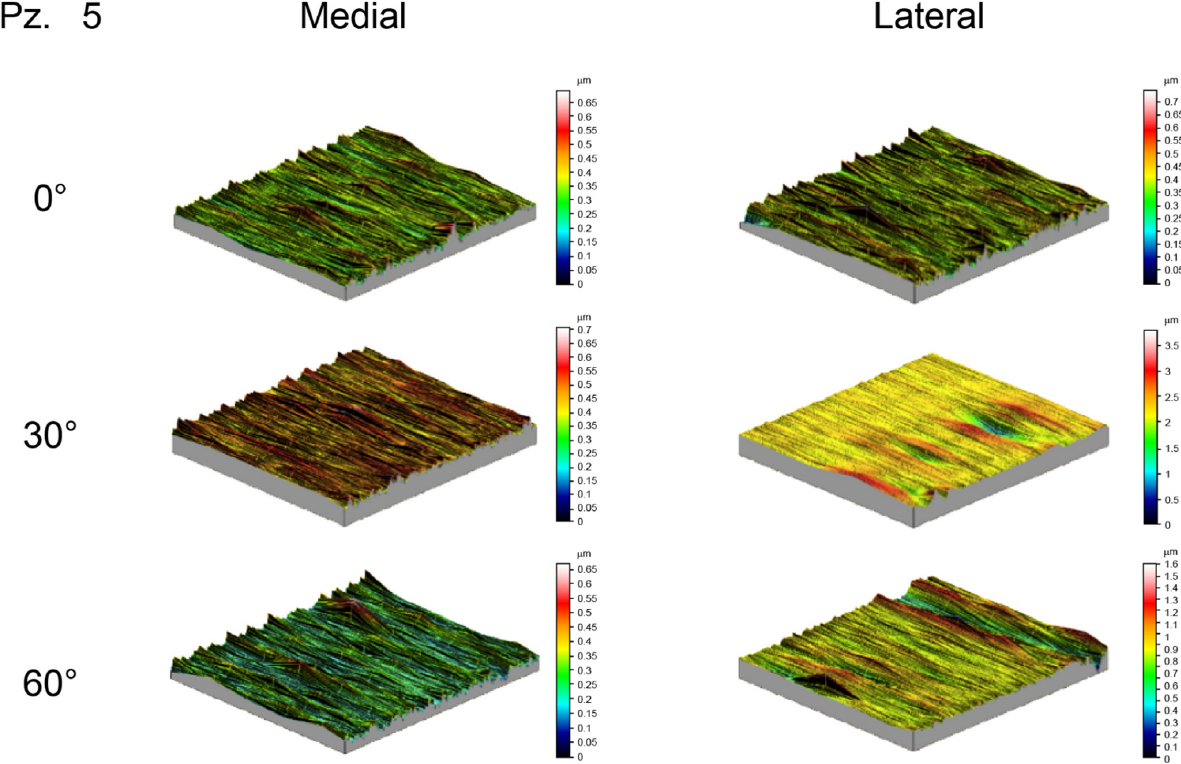
Figure 3. Topographical picture of the medial and lateral condyle with the medium Ra value.